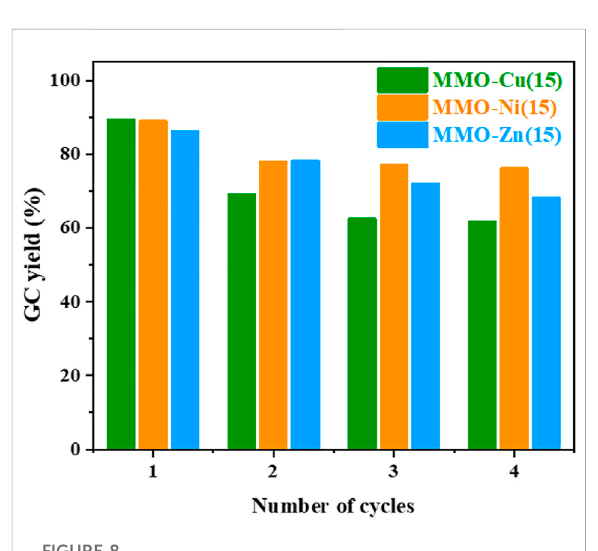
FIGURE 8 Glycerol carbonate yield of the used catalysts in four cycles.